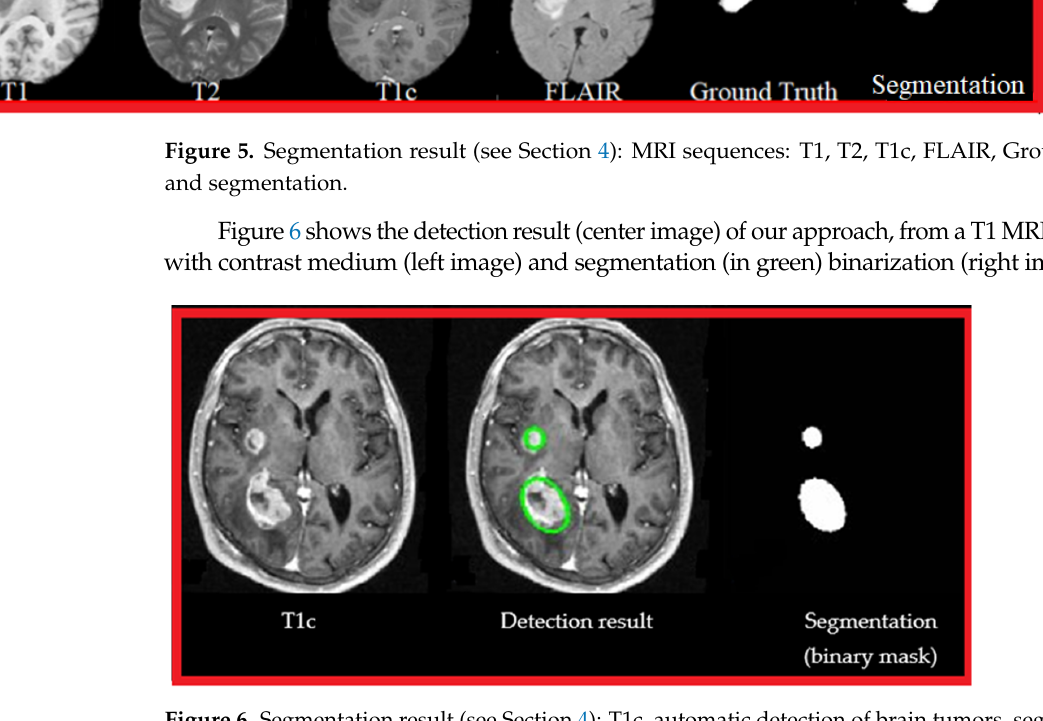
Figure 6. Segmentation result (see Section 4): T1c, automatic detection of brain tumors, segmenta ‐ tion, and binarization. and